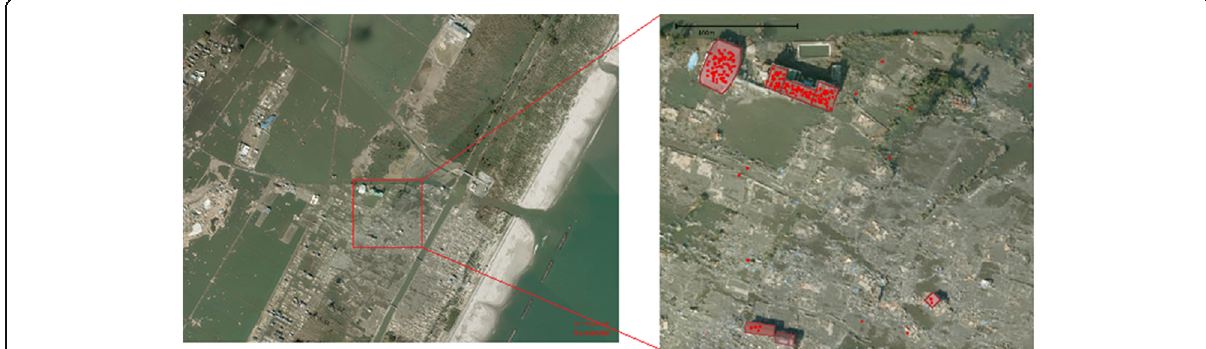
Fig. 9 Satellite photo of the town of Arahama taken on March 12, 2011 (Geospatial Information Authority of Japan 2011). Left is full photo, and right is sample of 300 m 2 sub-section built in DroneLab environment builder showing red buildings and red dot survivors. The large buildings in the upper left corner of the right photo are the ruins of the Sendai Arahama Elementary School, a primary evacuation site during the tsunami. Photograph by GSI of Japan (Geospatial Information Authority of Japan